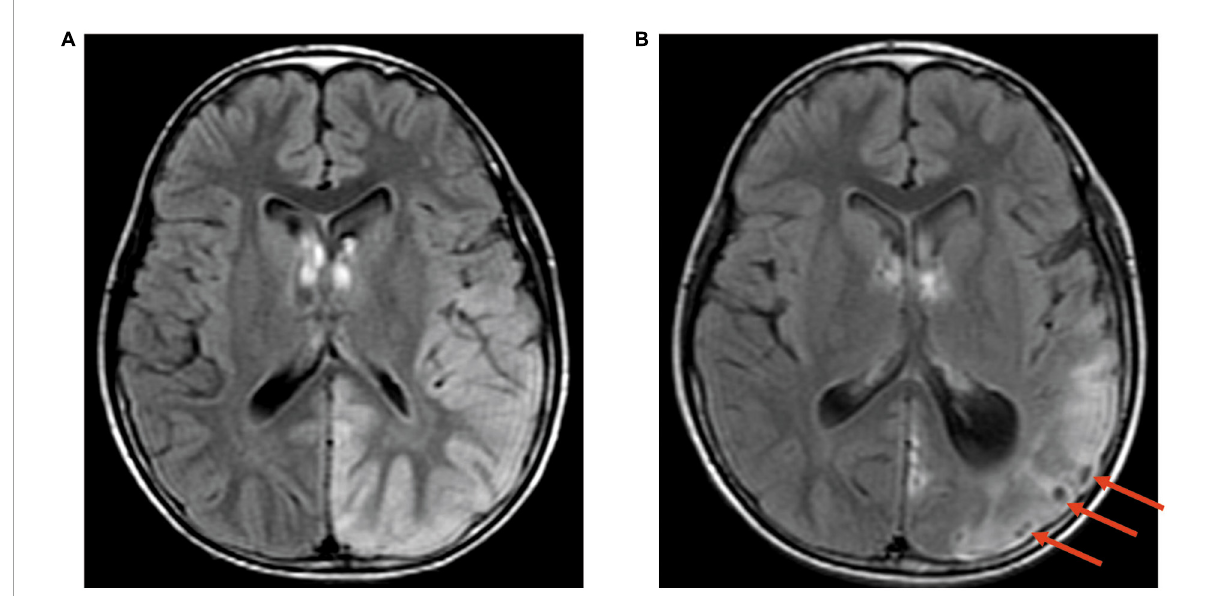
FIGURE3 The black toenail sign. Case 12, A 12-year-old boy with MELAS. (A) Transverse FLAIR images. Hyperintensity in the left temporoparietal occipital lobe; (B) Transverse FLAIR images. The same patient was examined 3 months later again. Cerebral atrophy was observed in the left temporoparietal occipital lobe with the “black toenail” sign (shown by the red arrow) on the top of the gyrus.